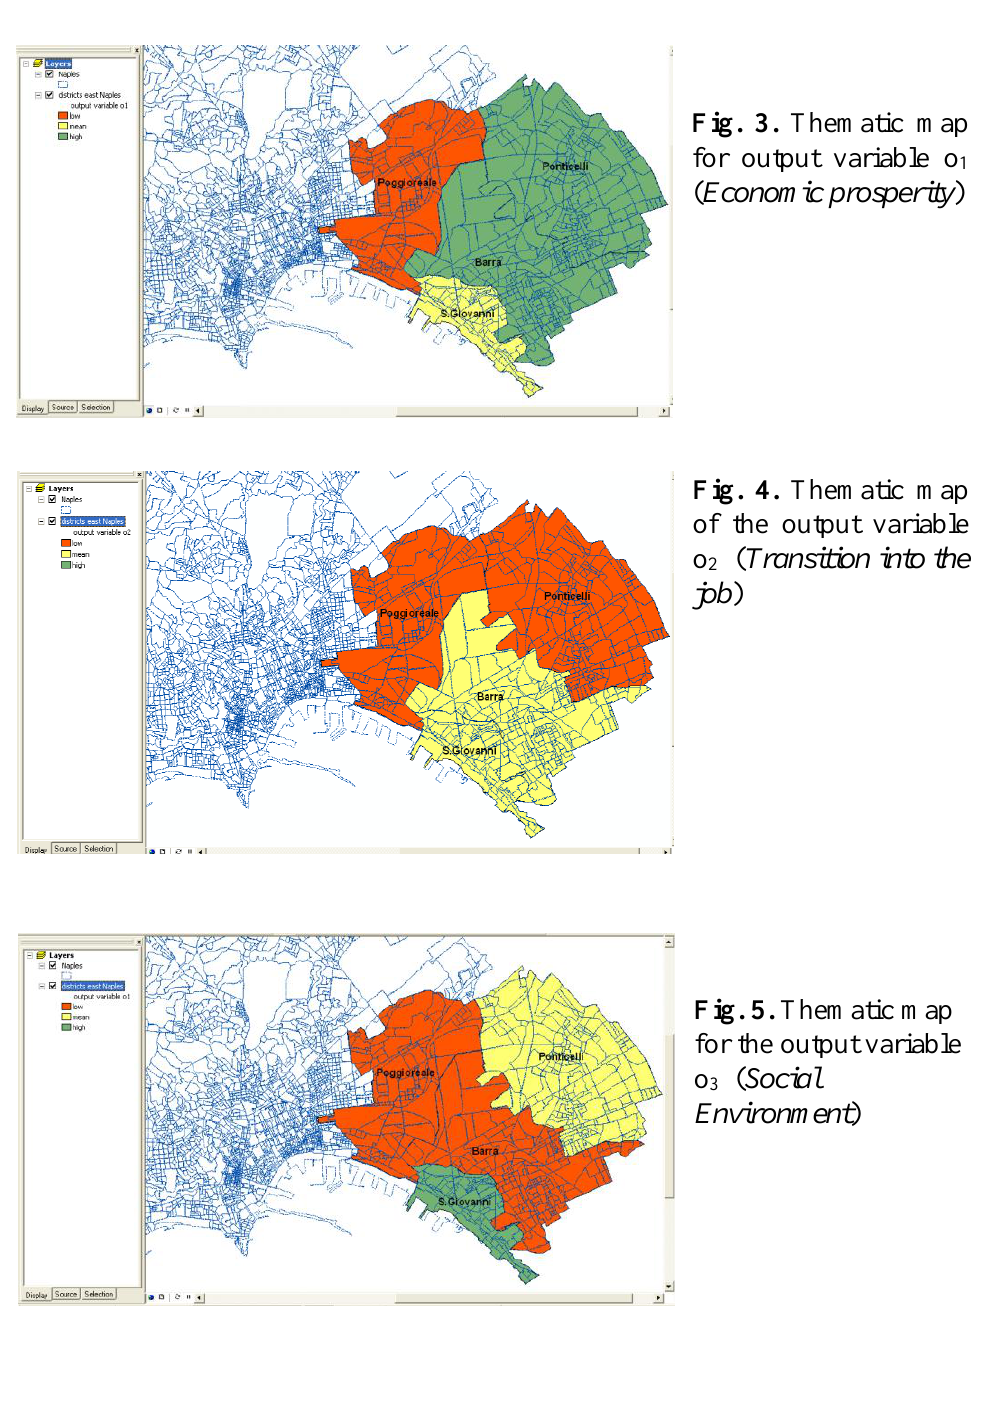
Fig. 3. Thematic map